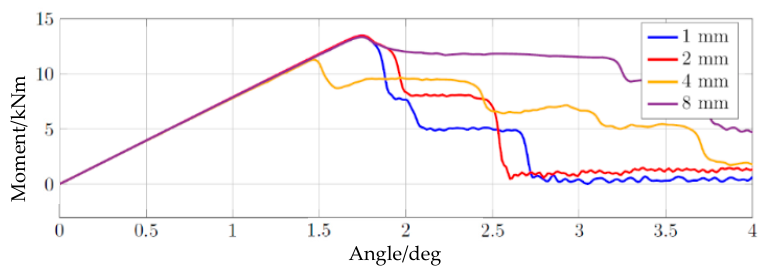
Figure 11. Results of the model in Figure 10b with different element side lengths.